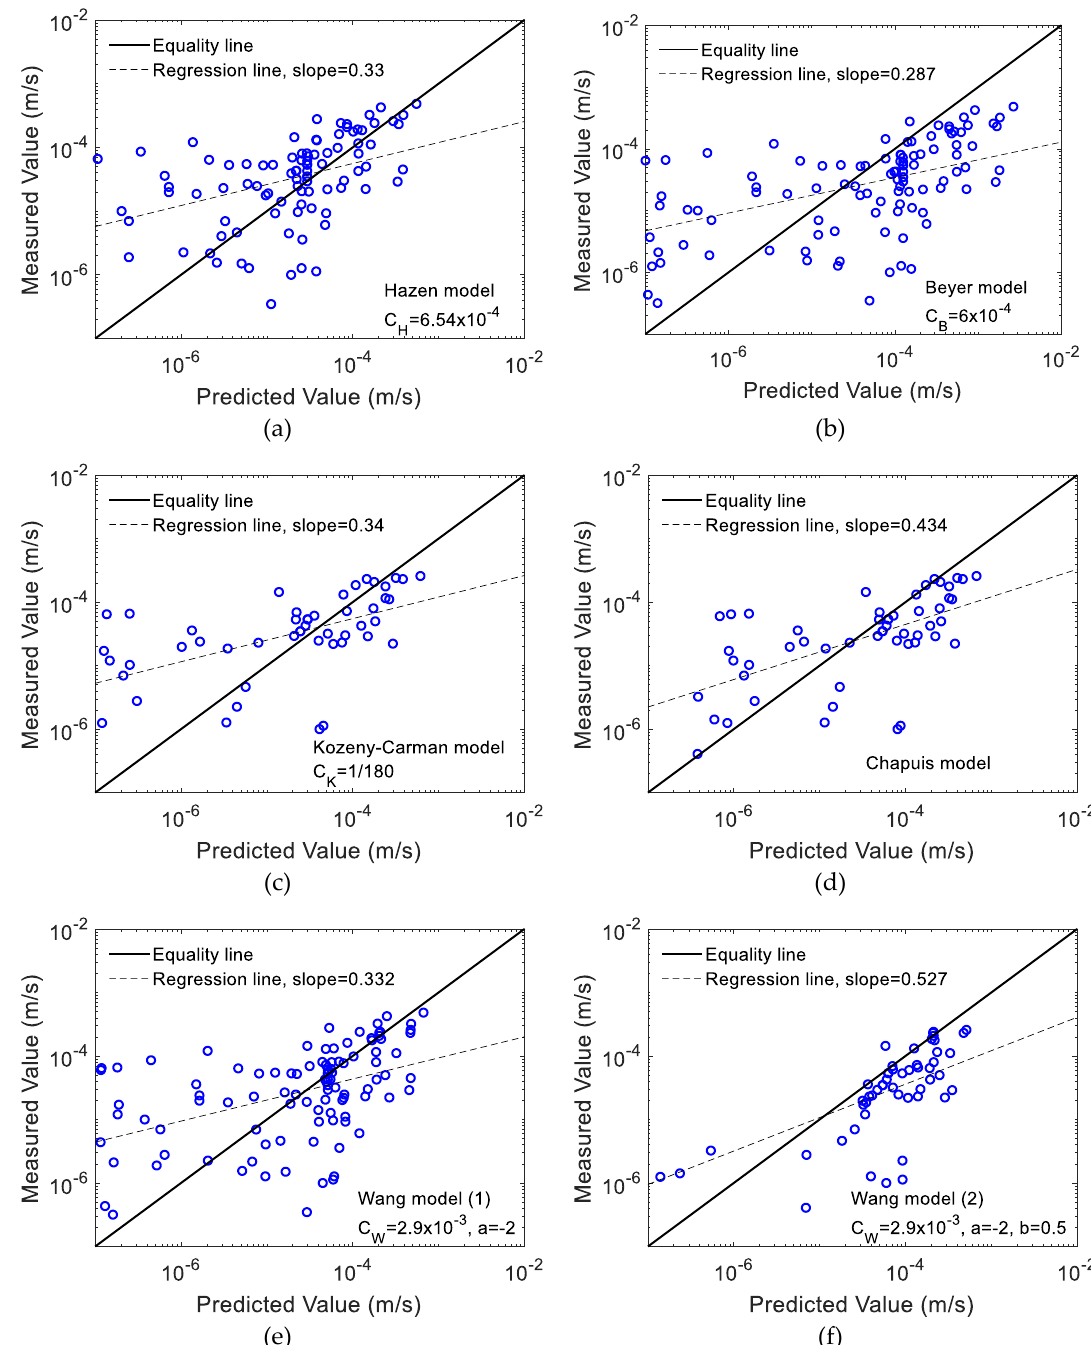
Figure 1. Prediction on saturated hydraulic conductivity of different models on soils from the UNSODA database. ( a ) Hazen model; ( b ) Beyer model; ( c ) Kozeny – Carman model; ( d ) Chapuis model; ( e ) model of Equation (6); ( f ) model of Equation (8).